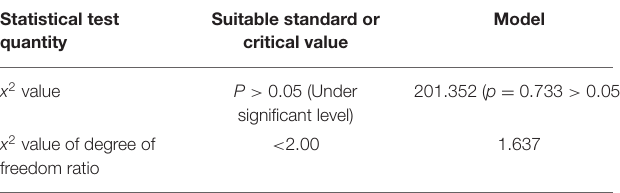
TABLE 10 | Chi square test results.